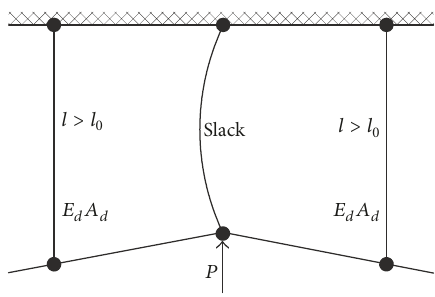
Figure 3: Slackening of a